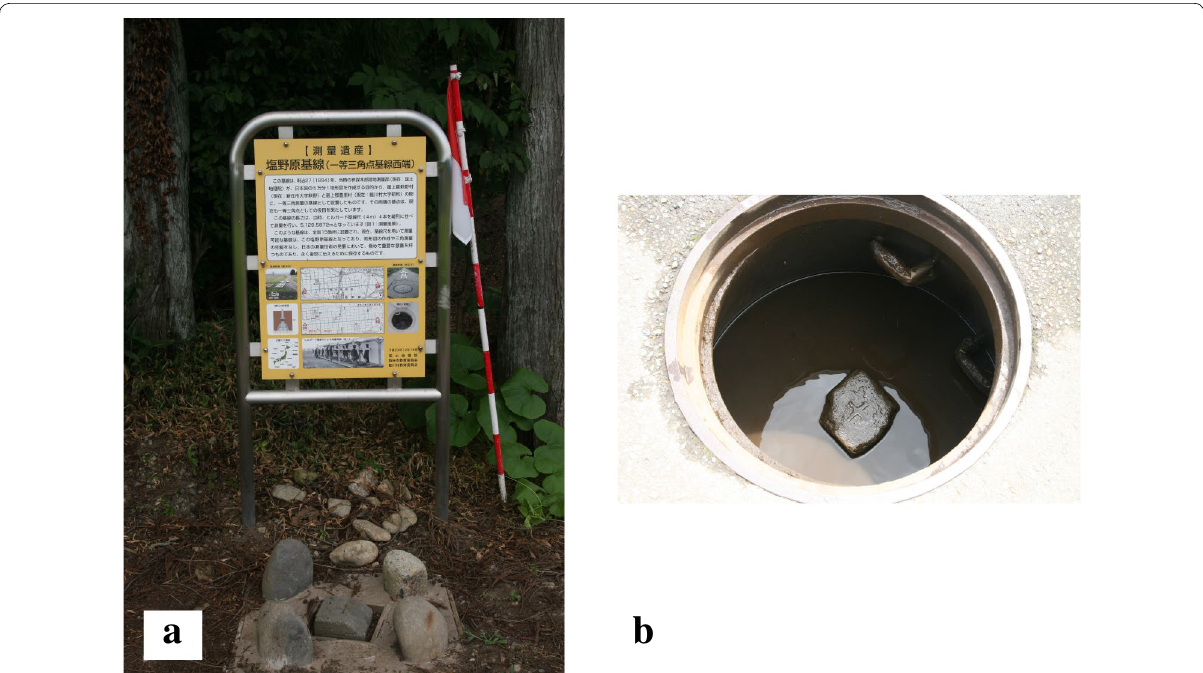
Fig. 8 Photographs of the first-order triangulation control points of the Shionohara baseline (photographs taken by T. Sagiya). a Western end. b Eastern end